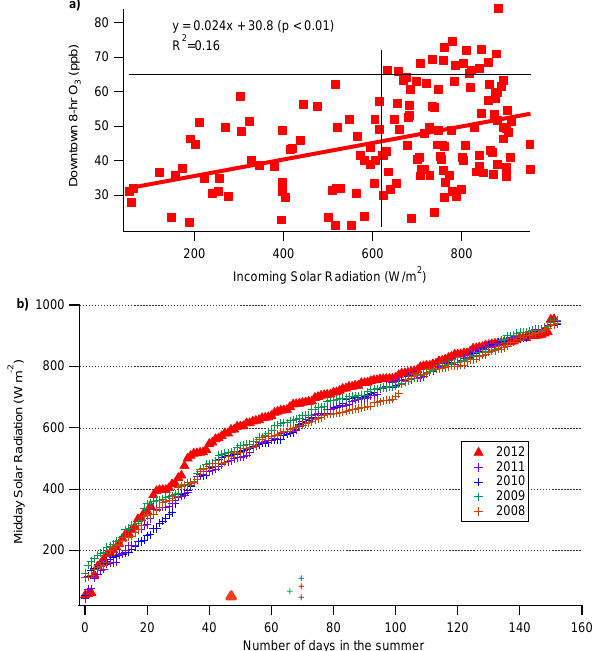
Figure 6. (a) Regression of Downtown2 8h O 3 versus incoming so- Figure 6: a) Regression of Downtown2 8-hr O 3 versus incoming solar radiation (W/m 2 ) for 2012 670 (black lines are the thresholds of incoming solar radiation where 65 ppb of O 3 is exceeded); b) 671 lar radiation (Wm − 2 ) for 2012 (black lines are the thresholds of in- Cumulative distributions of the midday average solar radiation (W/m 2 ) experienced on each 672 coming solar radiation where 65ppb of O 3 is exceeded); (b) Cumu- summer day (2008-2012) (markers above the x-axis are provided to easily identify the difference in 673 the number of days exceeding 600 W m -2 for 2012 and the previous four years). 674 lative distributions of the midday average solar radiation (Wm − 2 ) experienced on each summer day (2008–2012) (markers above the x axis are provided to easily identify the difference in the number of days exceeding 600Wm − 2 for 2012 and the previous four